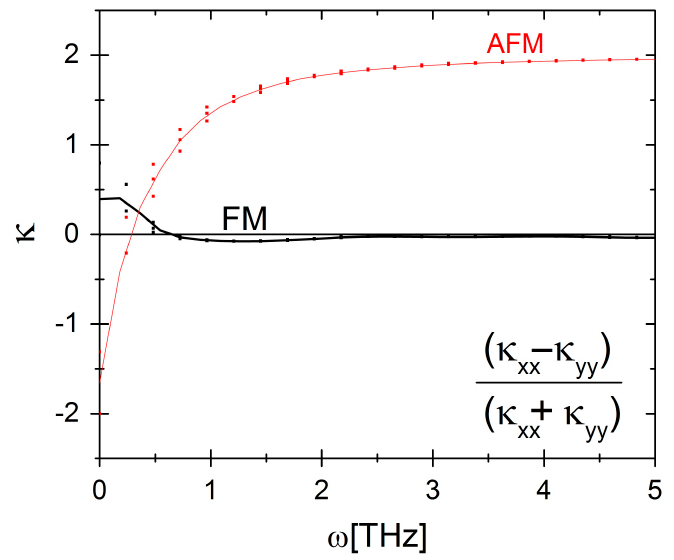
Figure 3. Extinction coefficient of CoO nanowire on Pt(322) in low oxidized state for FM and AFM spin configurations.